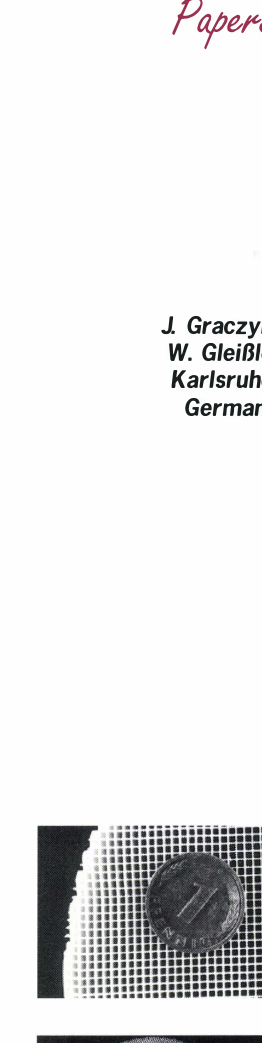
Fig. 1: Example of an extruded catalyst carrier (used for car exhaust